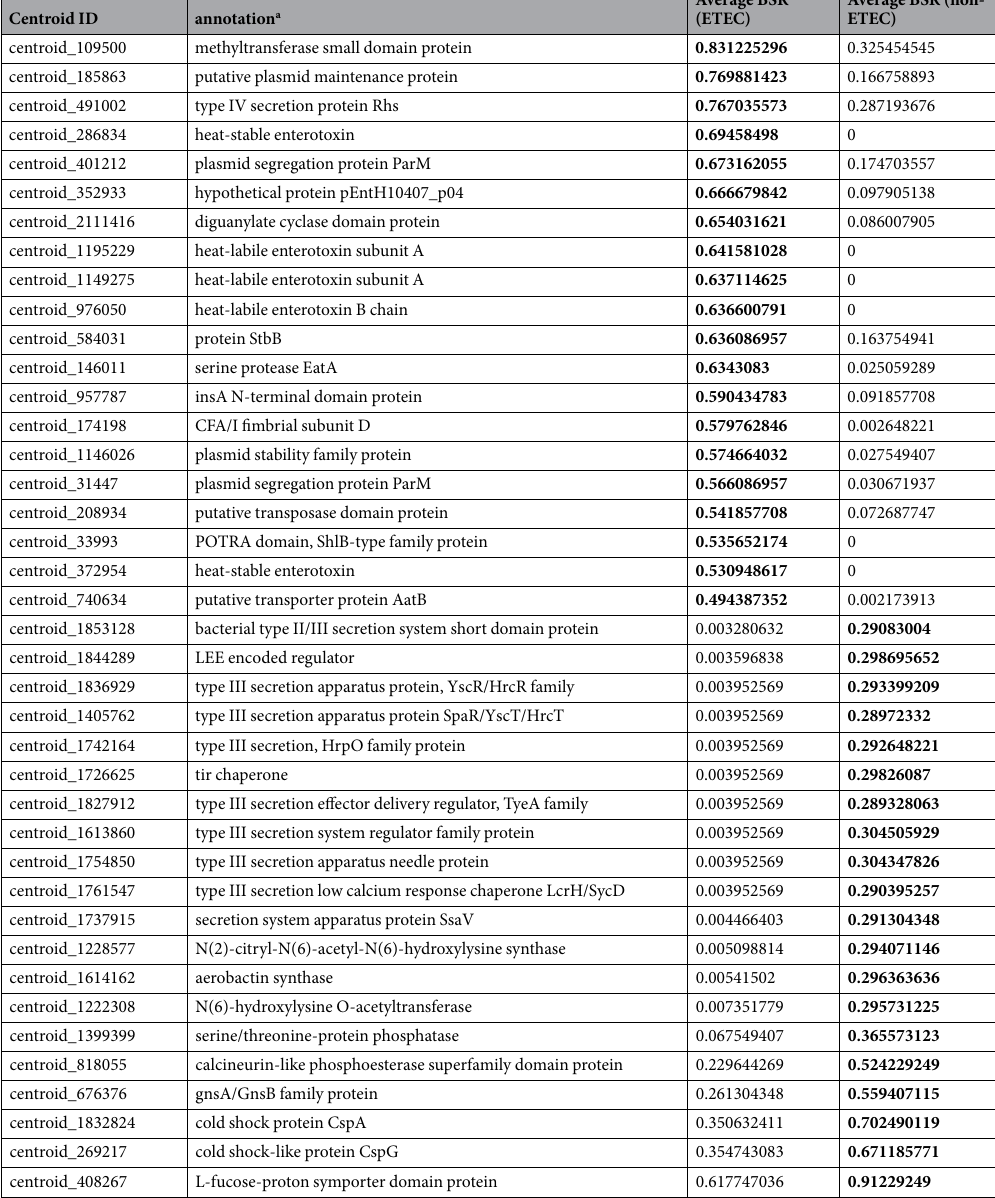
Table 2. Top 20 genes Identified as ETEC or non-ETEC specific. a Genes with annotation of hypothetical or conserved hypothetical have been removed from the table. The complete gene list is present in Supplemental Table S4. The bold values included in the table highlights which genes have an average LS-BSR suggesting ETEC (top of table) or non-ETEC (bottom of table)